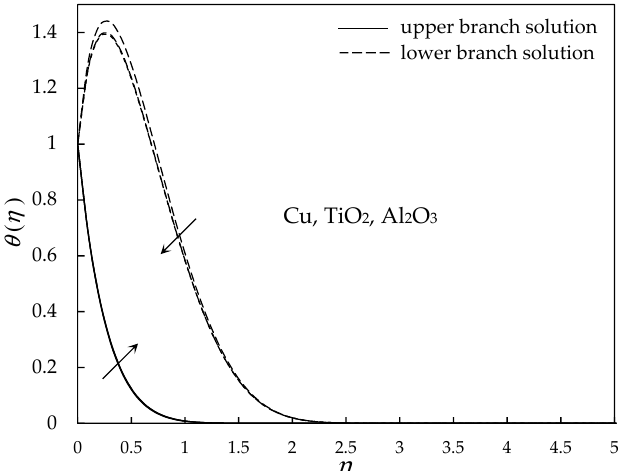
Figure 19. Temperature profiles θ ( η ) for Cu-water, Al 2 O 3 -water and TiO 2 -water nanofluids when φ = 0.01, Nr = 0.1, K = 0.1, s = 1, c = − 1 and λ = − 2 (opposing flow).